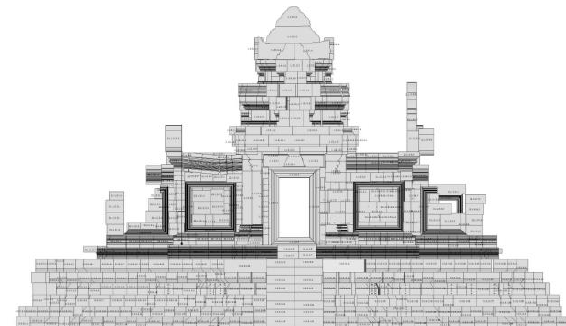
Figure 7. South elevation of the Outer South Gate of Ta Keo Temple, Angkor Monuments, Cambodia, generated from BIM model.